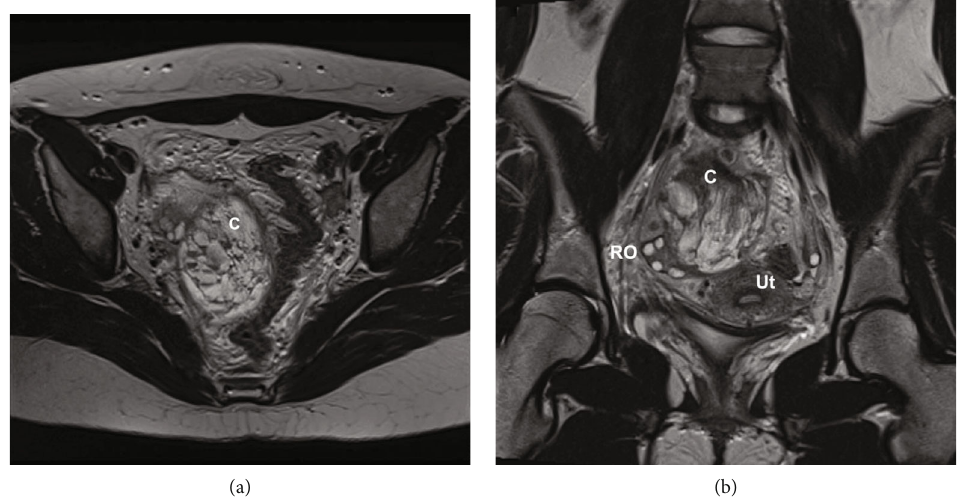
Figure 1: MRI of the pelvis. (a) (11) Axial T2-weighted image demonstrating the large complex cystic mass (C) located at the right hemipelvis. The lesion is multiloculated with internal haemorrhage seen as fl uid- fl uid levels and T2 shading (darker cyst content). (b) Coronal T2-weighted image with the normal right ovary (RO) is demonstrated lateral to the complex cystic mass (C). Large irregular low T2 signal intensity regions within the cystic lesion relate to blood products. Ut: